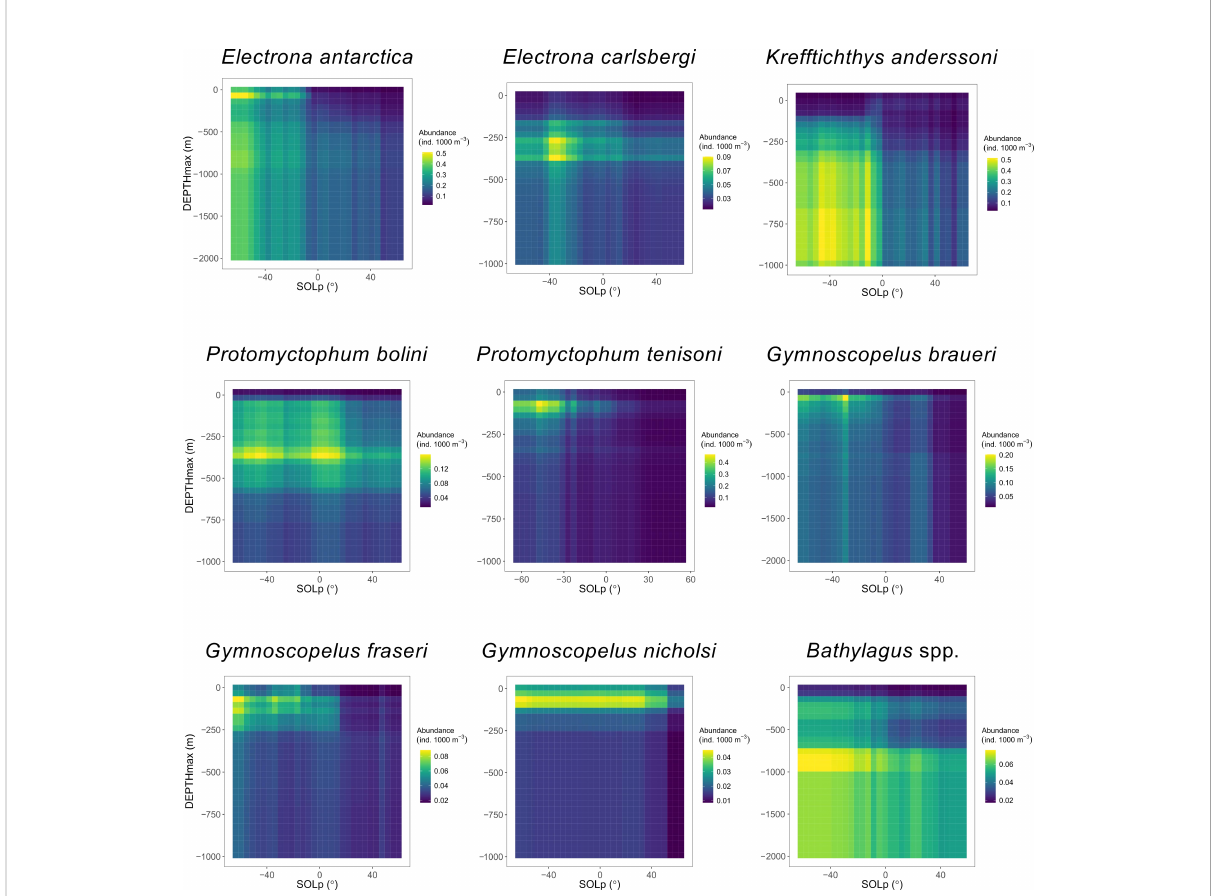
FIGURE 4 Predicted abundance of eight species of myctophid and the genus Bathylagus in relation to maximum depth (DEPTHmax) of the trawl, given the variation in solar position (SOLp; negative values indicate night-time, positive values indicate daytime) as predicted by species-speci fi c boosted regression tree models. Color depicts